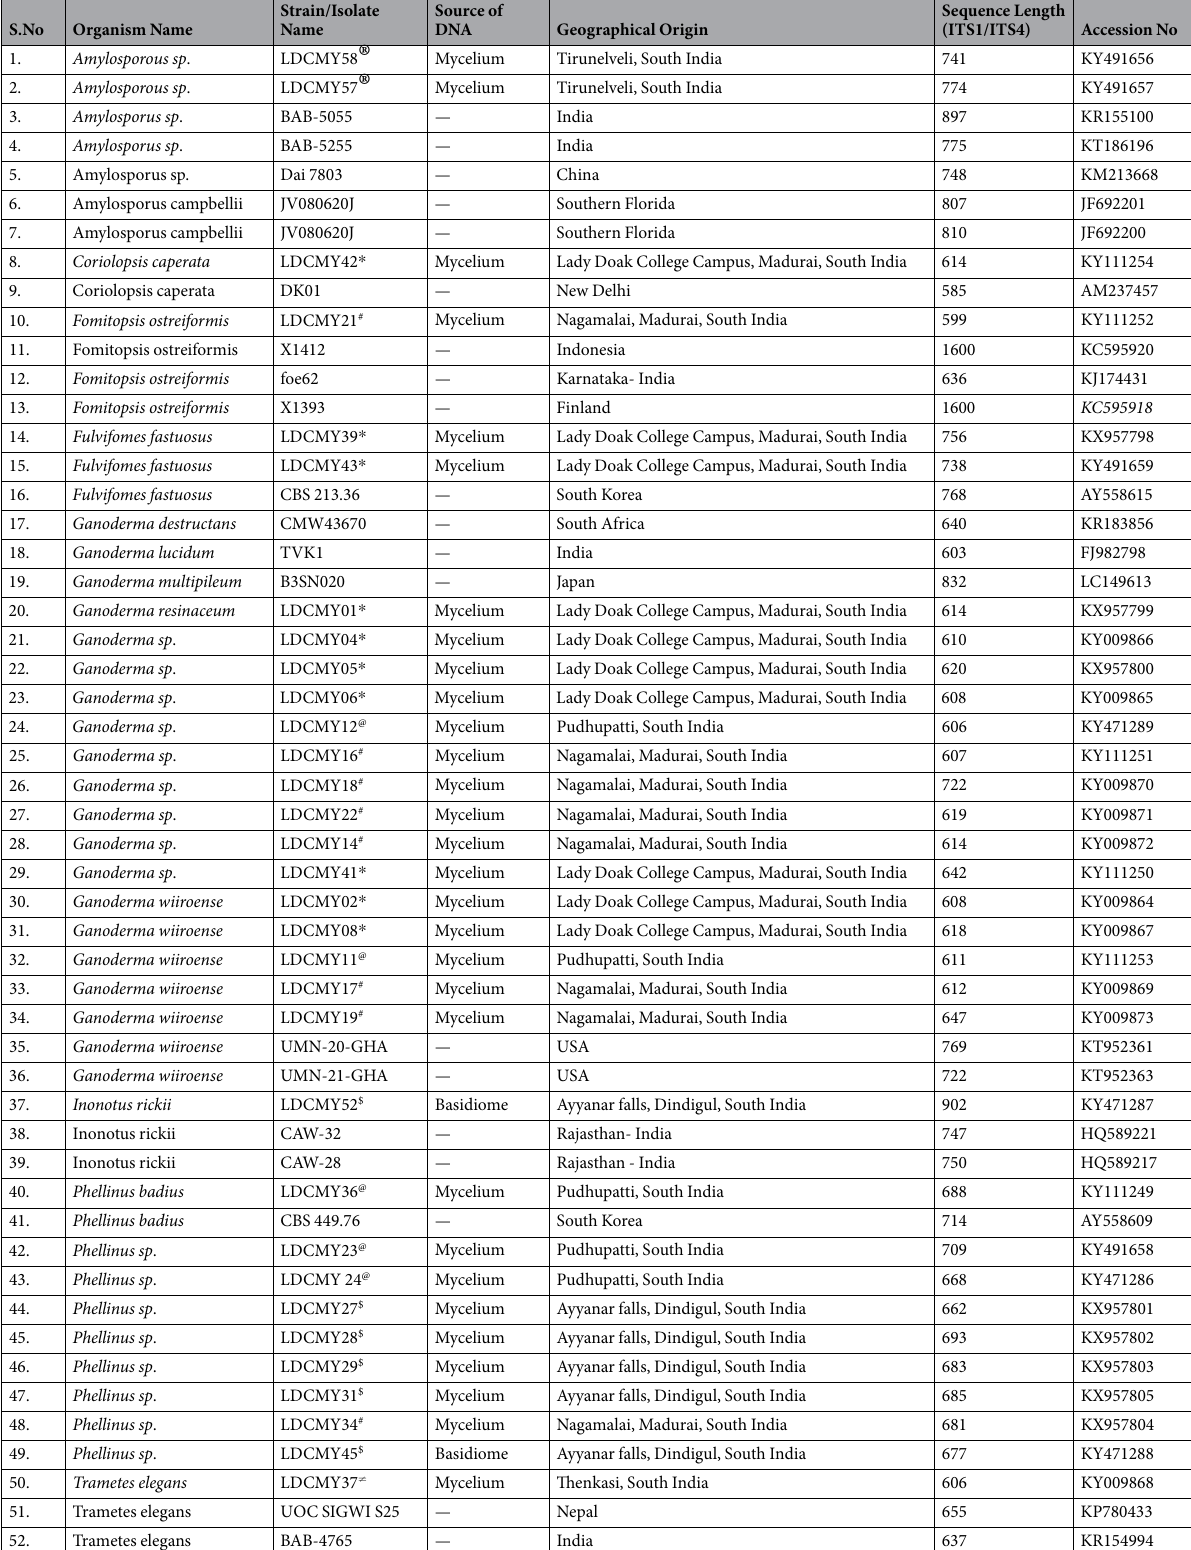
Table 3. Species and their GenBank accession number used for constructing molecular phylogeny. $,€, * ,#, ≠ ,@, ® Used to denote the sequence data generated from the strains collected from different places. $ Ayyanar falls; € Kovai kutralam * Lady Doak College Campus; # Nagamalai; ≠ Thenkasi; @ Pudhupatti; ®